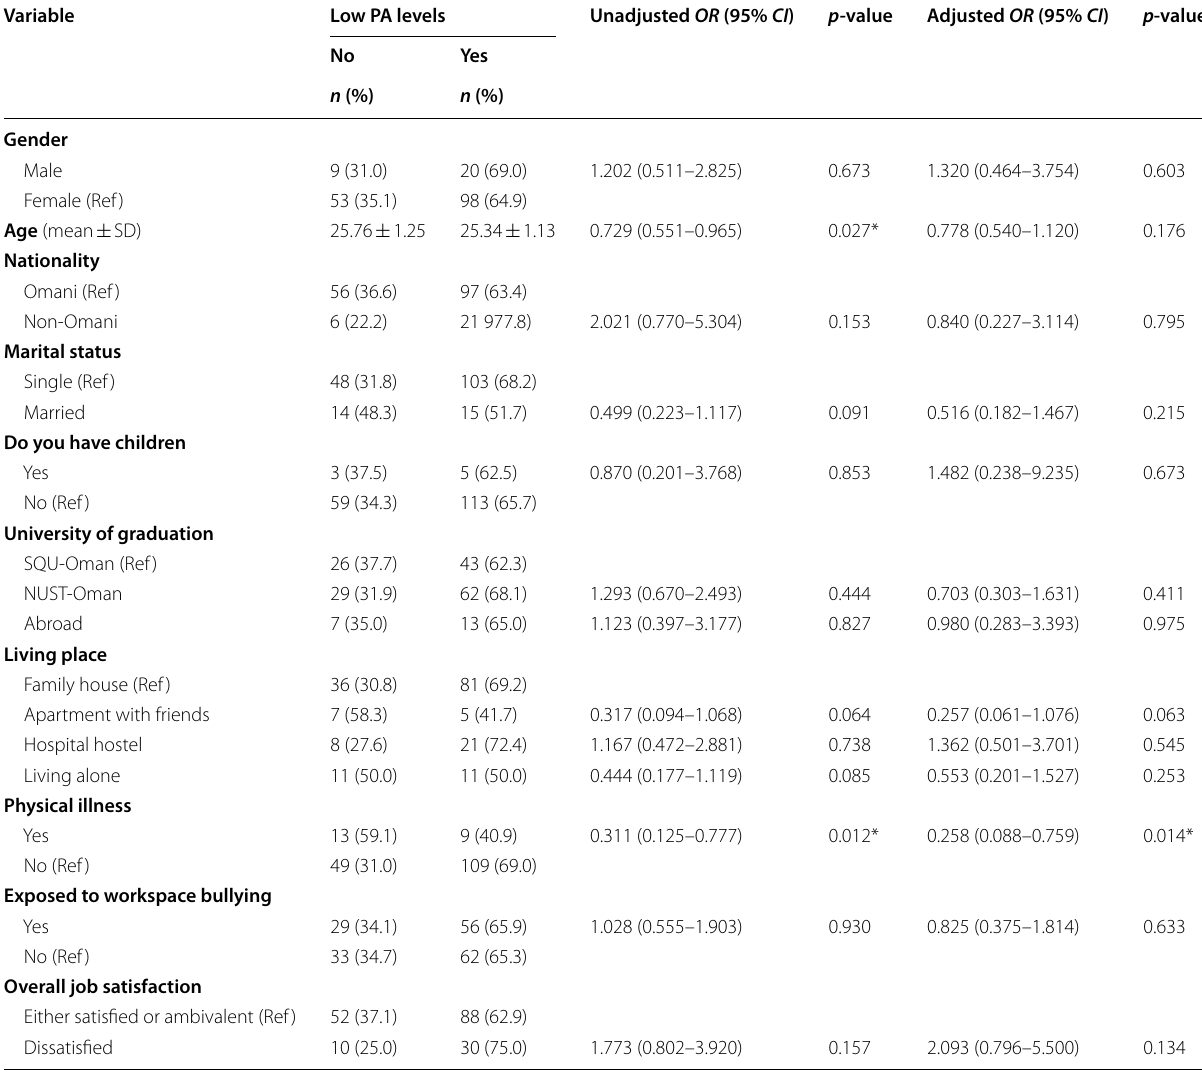
Table 4 Represents the results of univariate and multivariate analysis of data pertain to the low personal accomplishment (PA) burnout subscale and explanatory